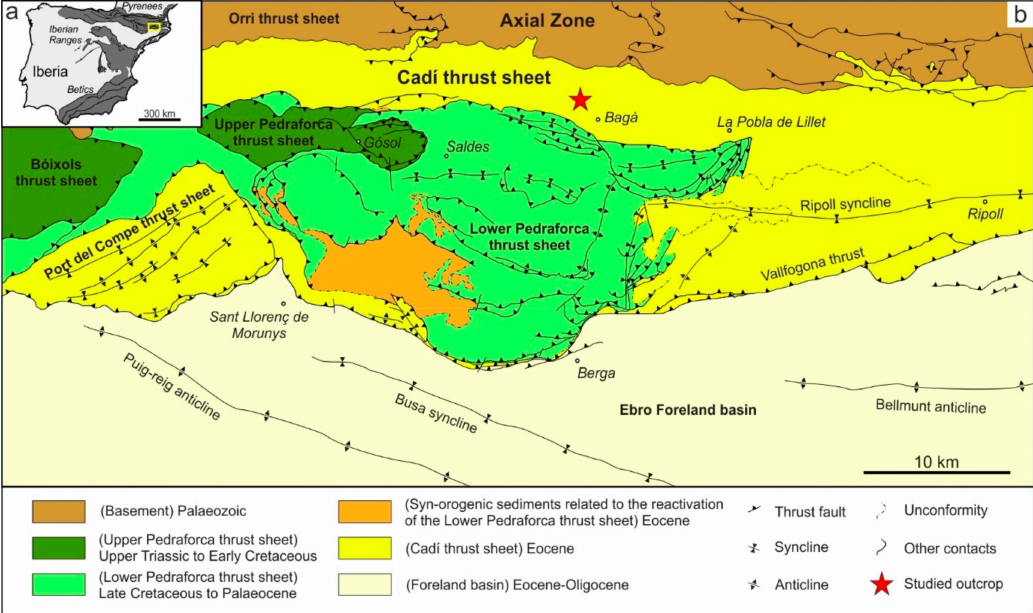
Figure 1. ( a ) Regional map of the Iberian Peninsula, showing the location of the Southeastern Pyrenees (yellow box). ( b ) Geological map showing the main structural units forming the Southeastern Pyrenean foldandthrustbelt, basedonReference[46–49].